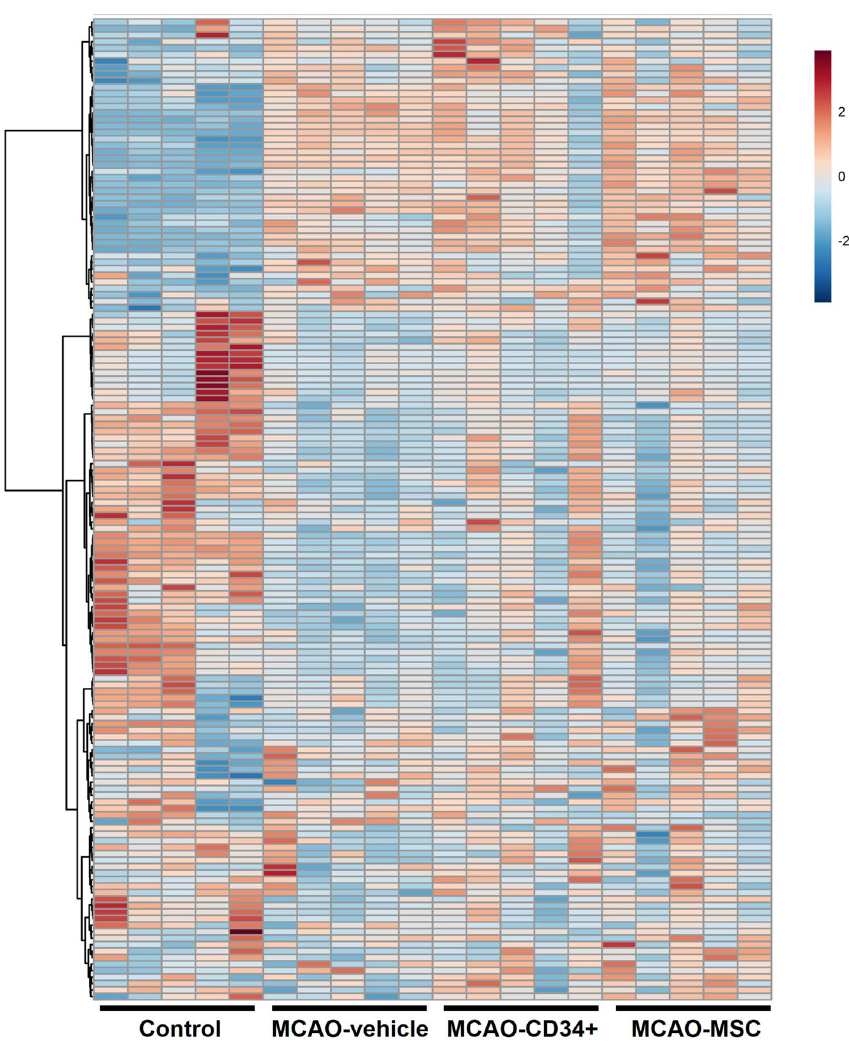
MetaboAnalyst ver. 4 (https ://www.metab oanal yst.ca/). Heatmap with labels are presented in Supplementary information